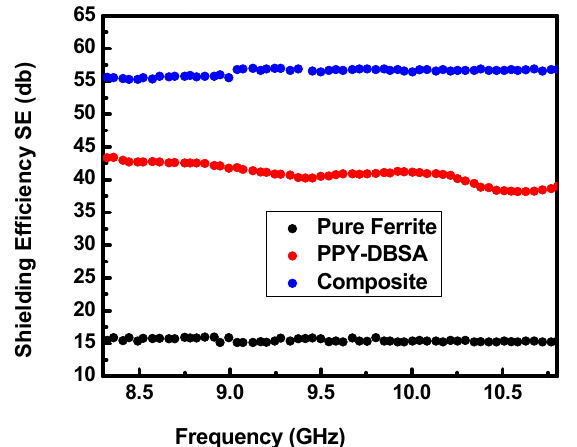
Figure 12. Variations of shielding efficiency of pure y-type hexaferrites, ppy-DBSA and ferrite-ppy-DBSA composite. The ability of any material to attenuate strength of electromagnetic waves is known as the electromagnetic shielding. It is a logarithmic ratio between incoming power (pi) to transmitted power (pt)of electromagnetic waves in decibels (dB).